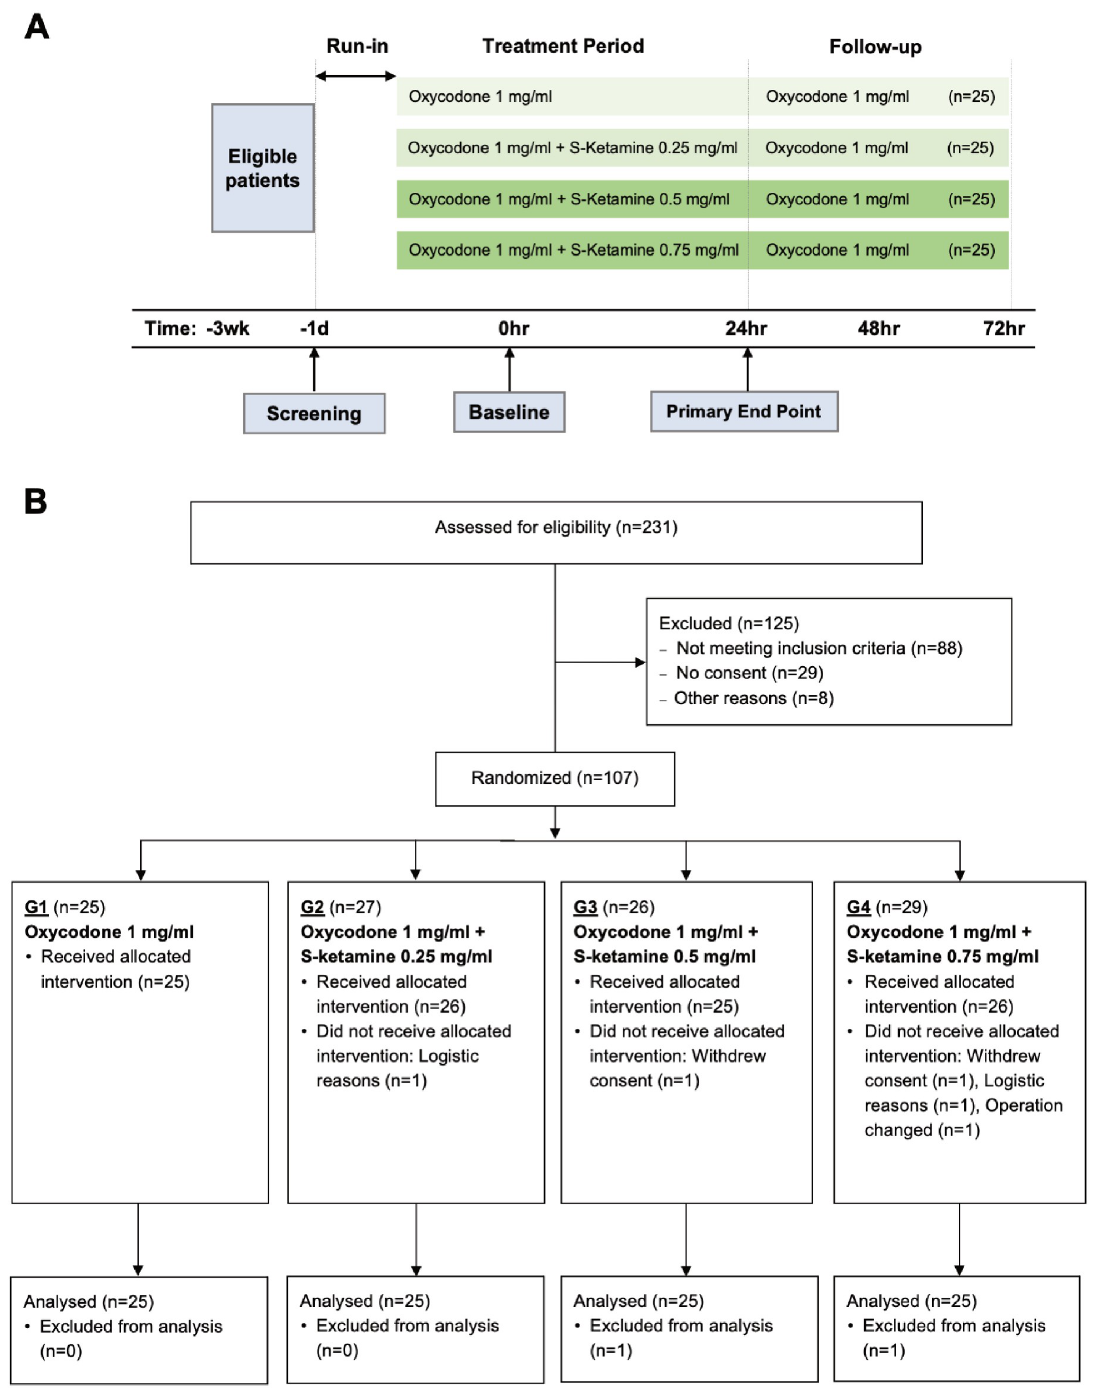
Fig 1. DoseRespKeta trial structure and CONSORT 2009 flow diagram. CONSORT indicates Consolidated Standards of Reporting Trials.